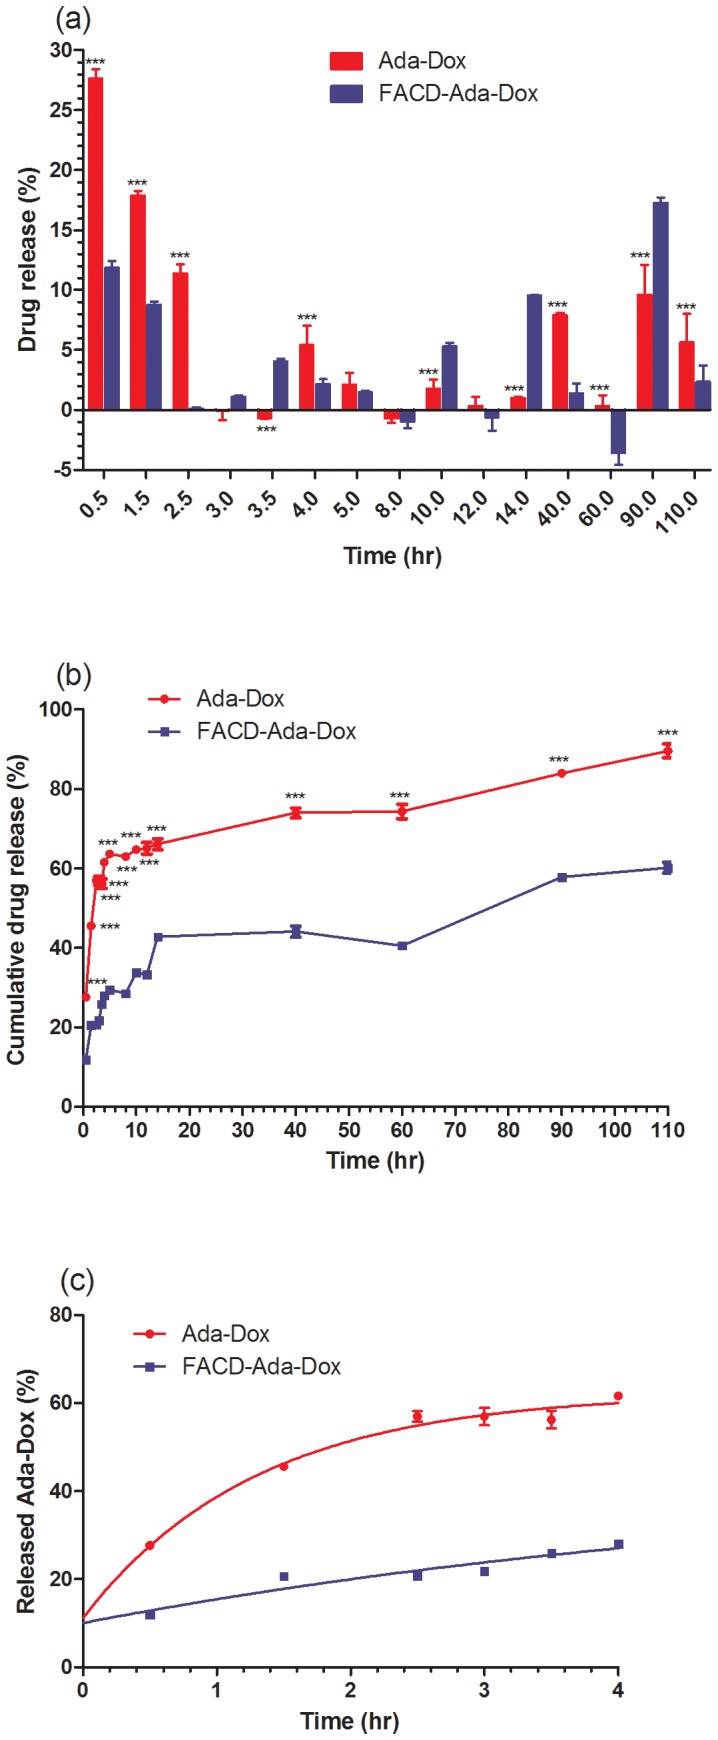
The drug release profiles of Ada-Dox and FACD-Ada-Dox.Plots a and b show the absolute and cumulative drug release profiles, respectively. Plot c illustrates the release kinetics and best fit of curves when drug release was calculated up to 4 hr only. The release of Ada-Dox was determined by a dialysis method. The released Ada-Dox was quantified by microplate reader at λEx = 490 nm and λEm = 600 nm. A calibration curve was prepared using different concentrations of free Ada-Dox. ***
P<0.001.